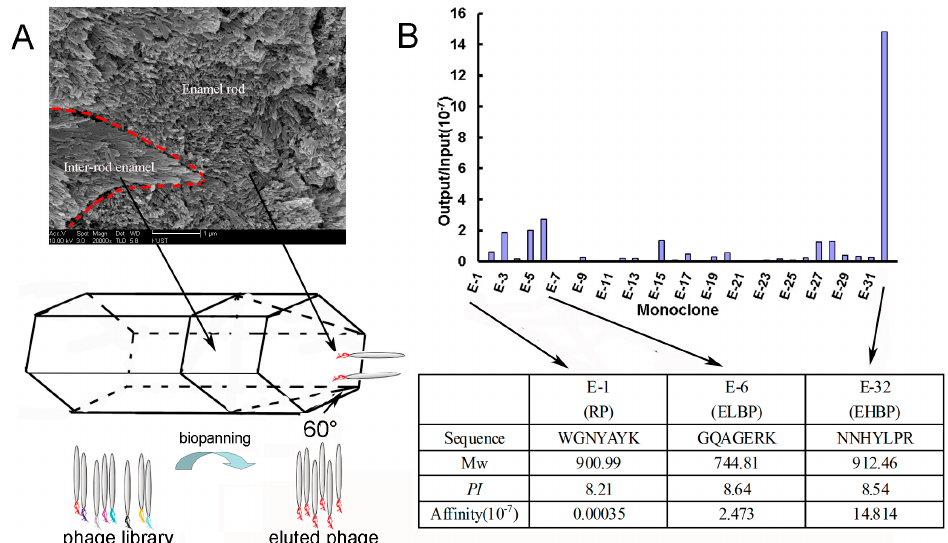
Figure 1. ( A ) FSEM observation of enamel surface after deproteinization showed the enamel rod and inter-rod enamel (( A ), upper), which was schemed in ( A ), middle. The lower in ( A ) describes the procedure of biopanning from phage pool against the enamel surface; ( B ) 32 monoclones of phage from the original pool and the fourth-round panning was chosen to determine their affinity against the enamel surface through output/input assay. The peptide sequences and physicochemical